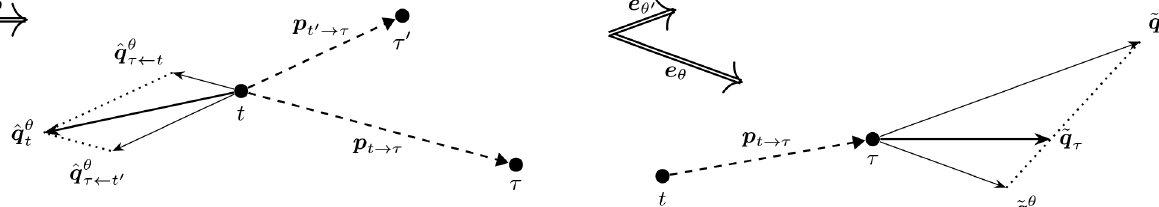
Figure 4. Illustration of how turbine-specific push-back pseudo- gradient vectors combine into a combined push-back pseudo- gradient vector.